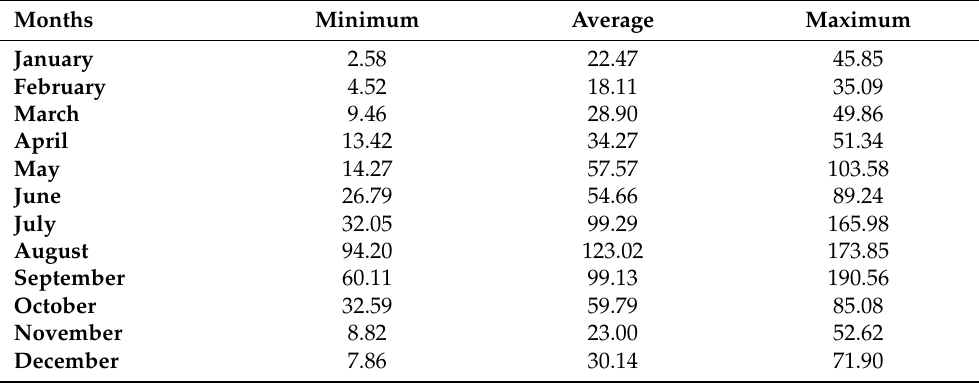
Table 2. Simulated characteristic monthly discharges in 2017–2021 on the Subarnarekha river.